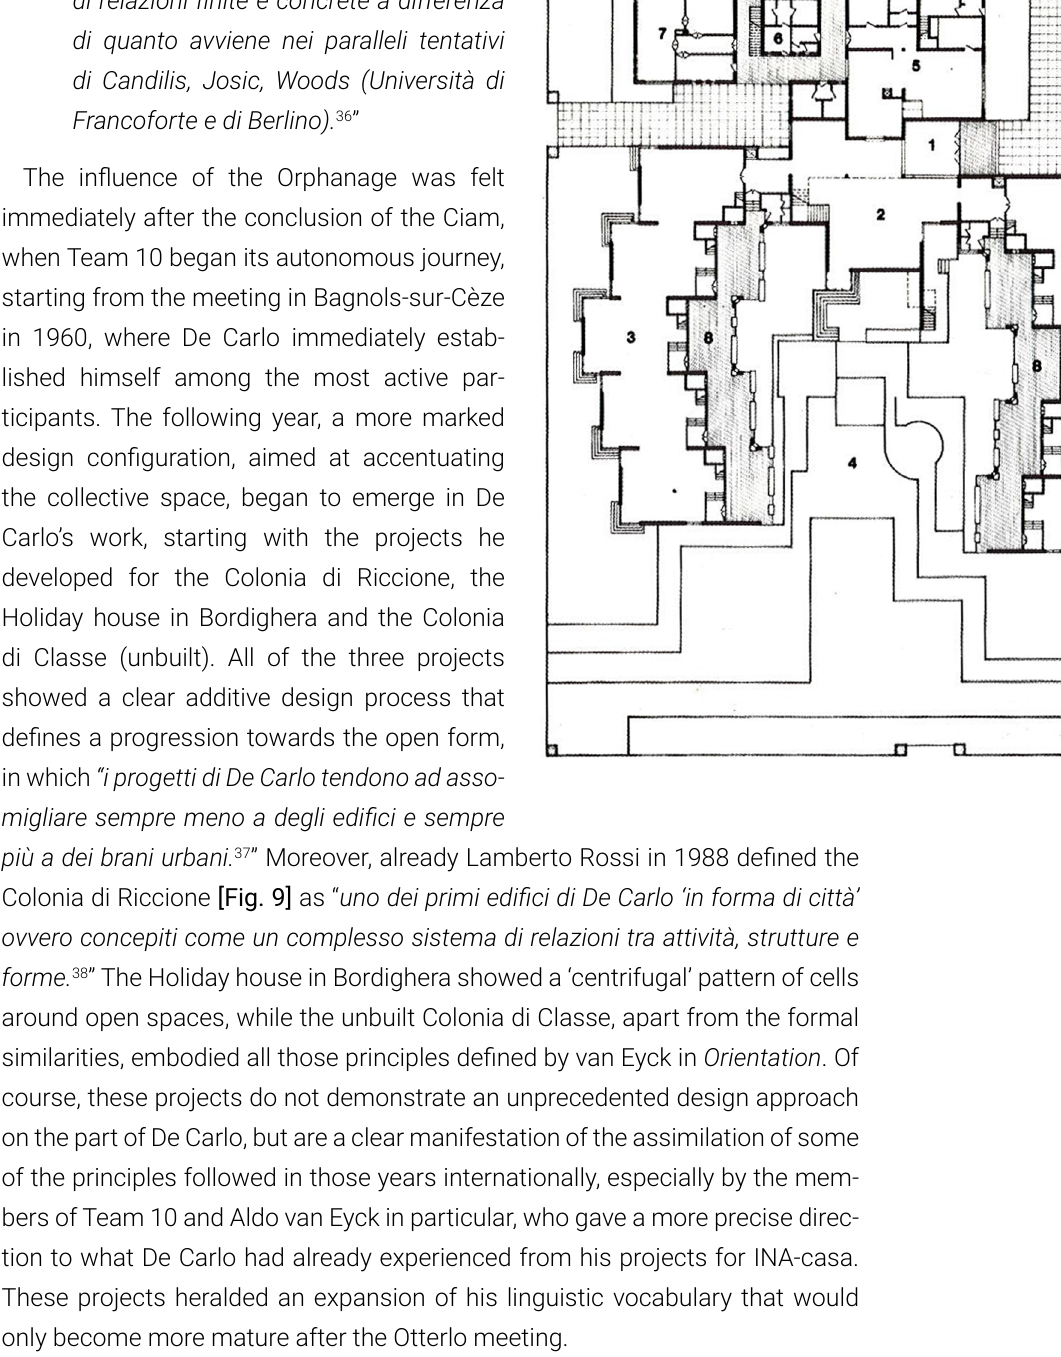
Fig. 9 Giancarlo De Carlo, Colonia di Riccione, ground floor plan. From: Lamberto Rossi. Gian- carlo De Carlo. Architetture. Milan: Arnoldo Mondadori Editore,